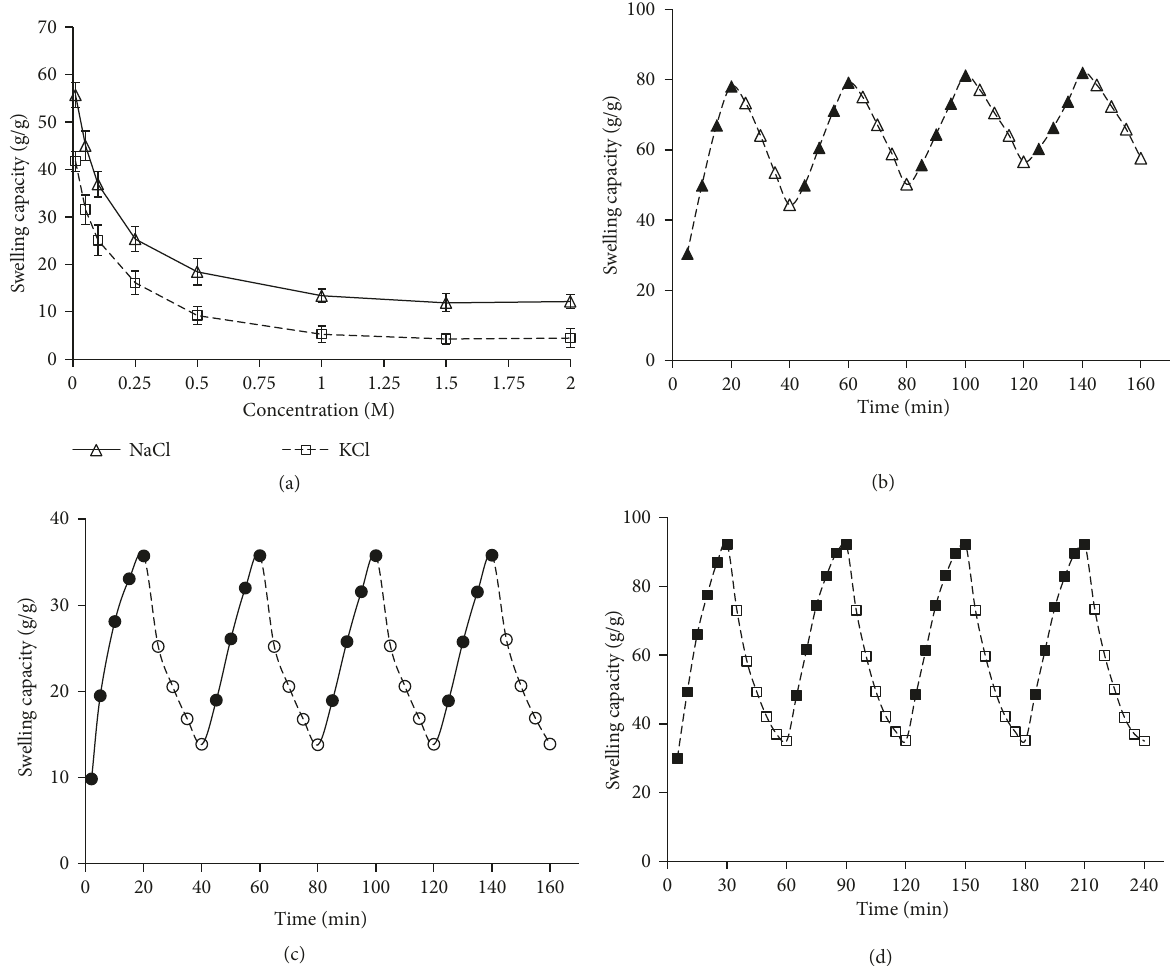
Figure 2: Equilibrium swelling capacity (after 24 h) of BSH in different molar solutions of NaCl and KCl (a). Swelling-deswelling (on-off switching) of BSH in deionized water and normal saline (b), basic (pH 7.4) and acidic (pH 1.2) media (c), and deionized water and ethanol